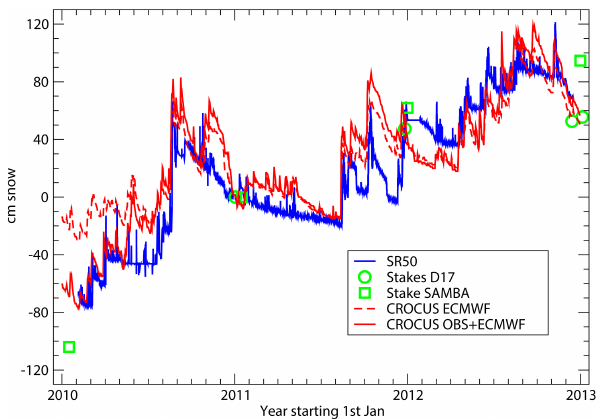
Figure 8. Observed (ADG in blue, GLACIOCLIM-SAMBA and D17 stakes in green) and simulated (Crocus model with ECMWF meteorology in red dashed line, with combined ECMWF and ob- served meteorology in red solid line) snow-pack height evolution over